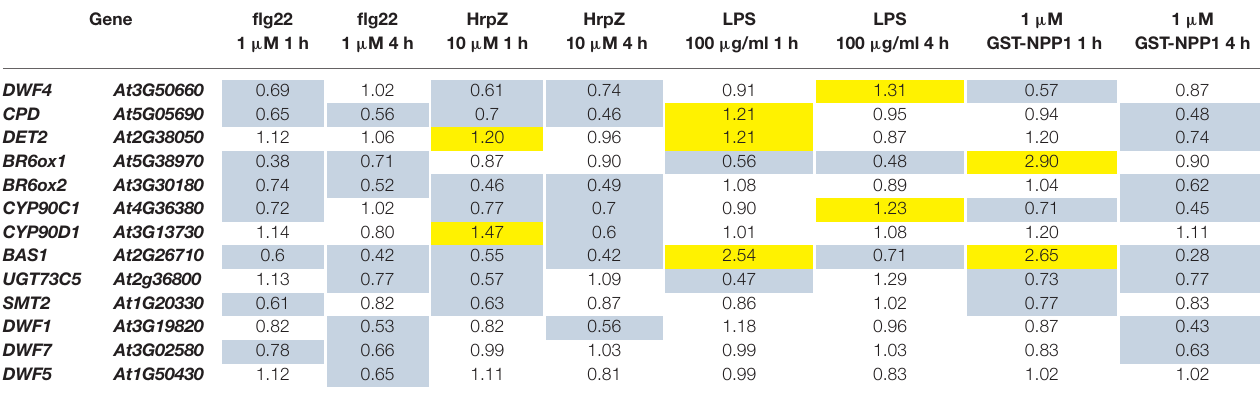
TABLE 1 | Expression changes in BR biosynthetic genes in response to treatment with different PAMPs. Gene flg22 flg22